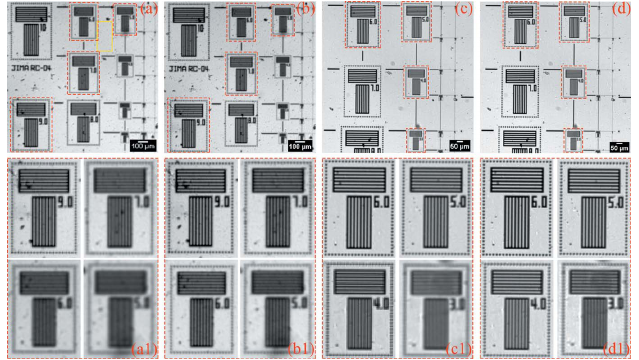
Figure 13 Experimental results verifying the effect of the translational accuracy on the micro-scanning method. ( a ) The projection (pixel size: 6.5 m m (cid:2) 6.5 m m; pixel number: 230 (cid:2) 230) and ( b ) the oversampled image with deconvolution (pixel size: 3.25 m m (cid:2) 3.25 m m; pixel number: 460 (cid:2) 460) in the case of high translational accuracy. ( c ) The projection (pixel size: 3.25 m m (cid:2) 3.25 m m; pixel number: 360 (cid:2) 360) and ( d ) the oversampled image with deconvolution (pixel size: 1.625 m m (cid:2) 1.625 m m; pixel